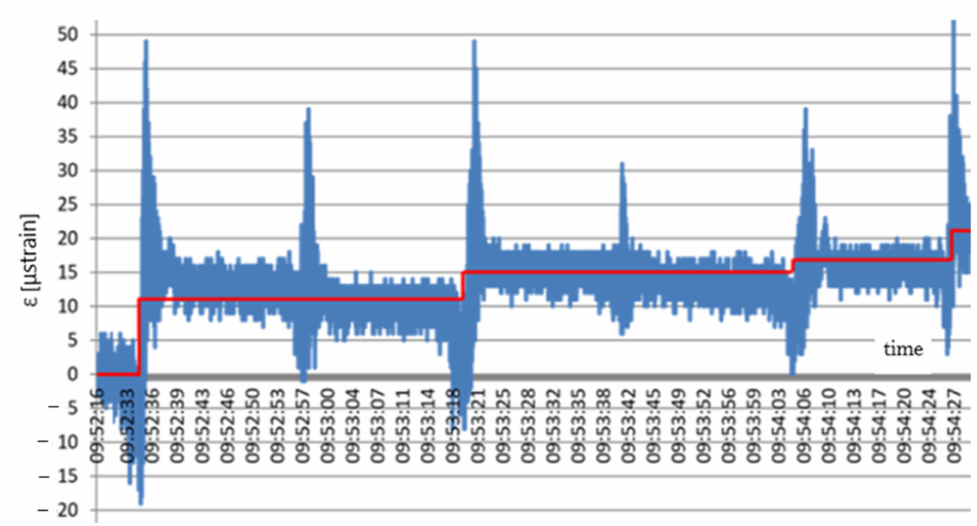
Figure 8. Scheme strains in the geogrid based on a concrete slab: x (s); y ( µ strain).